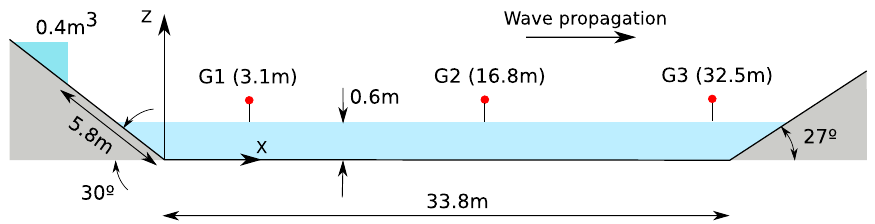
Fig. 9 Landslide wave problem. Setup of the LGW flume for the experimental and numerical analyses